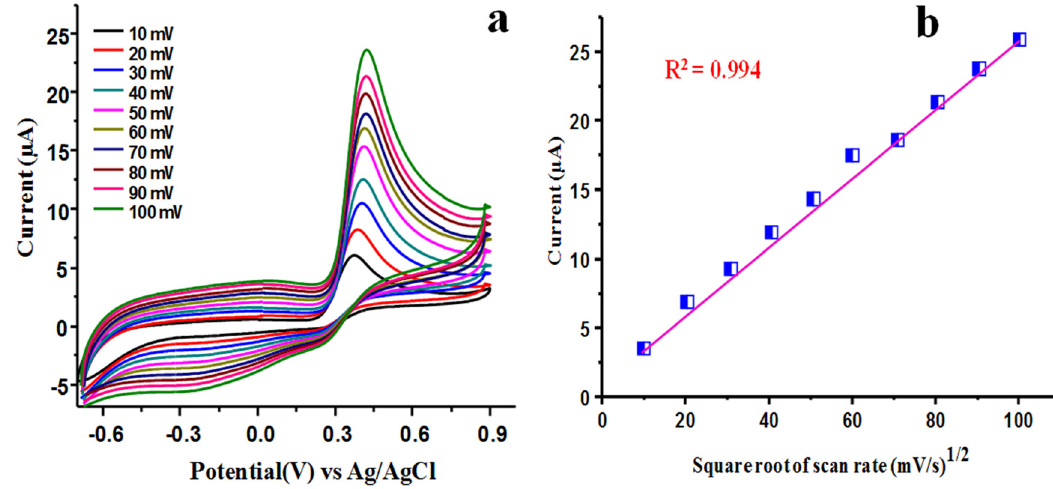
Figure 5: ( a ) CV response of 1 mM of UA at di ff erent scans and ( b ) anodic peak current vs square root of scan